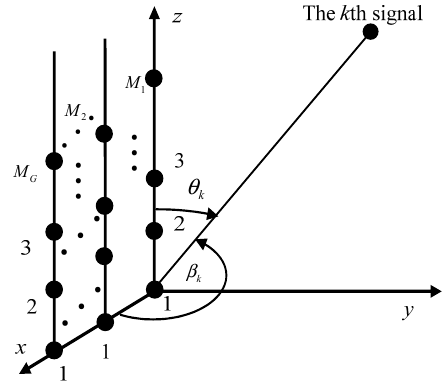
Figure 1. Array geometry of the G parallel linear arrays.